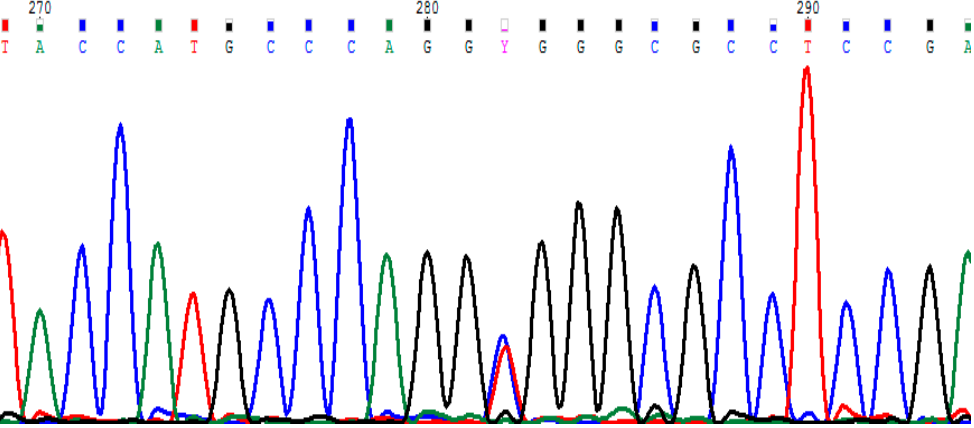
Figure 1. Sequencing results showing the polymorphic site in the bovine THRSP gene, Y—heterozygous genotype ( CT ).